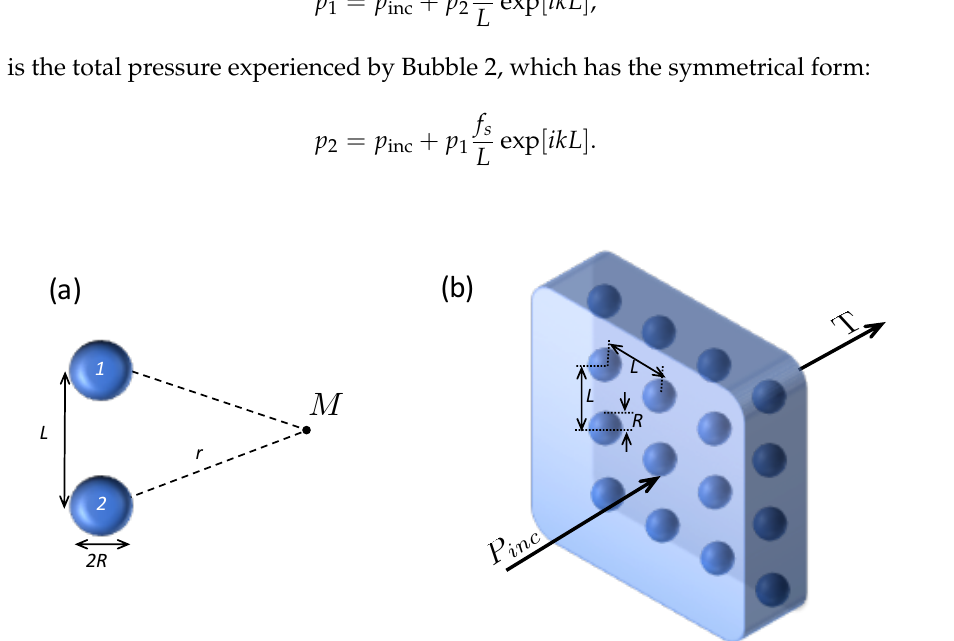
Figure 1. ( a ) A pair of R -radius bubbles, separated by a distance L . ( b ) An infinite array of R -radius bubbles, with a lattice distance L , excited by a plane wave with amplitude P inc